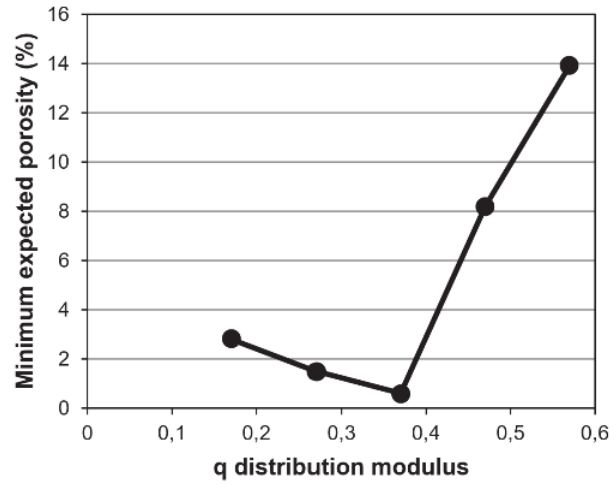
Minimum porosity calculated by the Westmann and Hugill modified model according to the distribution module, minimum grain of 0.17 μm and maximum of 16 mm (FUNK and DINGER,